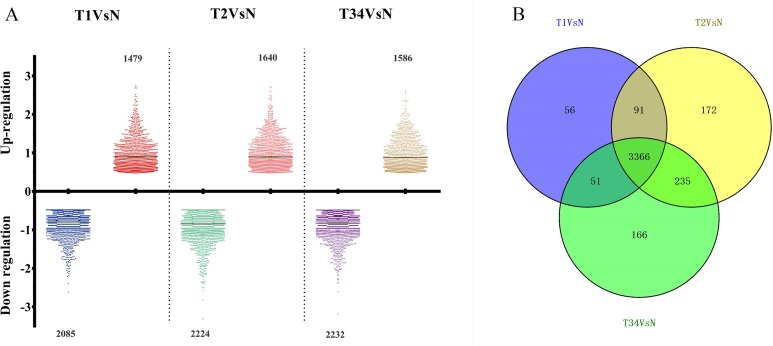
The number of differentially expressed genes obtained from the TCGA data among LUSC groups and controls.(A) Three thousand, five hundred sixty-four mRNAs were differentially expressed between the early-stage group “T1” and control group “N,” 3,864 mRNAs were differentially expressed between the mid-stage group “T2” and control group “N,” and 3,818 mRNAs were differentially expressed between the late-stage group “T3” and control group “N.” (B) Venn diagrams represent comparison of known and novel miRNAs among three data sets. The number marked in the overlapping areas indicates the common miRNAs. The control “N” represents adjacent non-tumor tissues.